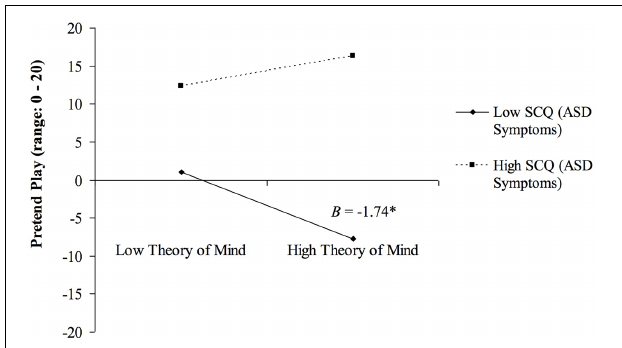
FIGURE 1 | Values below 0 are model-predicted values. Interaction between Social Communication Questionnaire [SCQ; i.e., history of many versus few autism spectrum disorder (ASD) symptoms] and theory of mind (ToM) Scale scores predicting amount of observed pretend play. Among those with low SCQ, a negative relation was found between ToM and pretend play. ∗ p < 0.05. Low = 1 SD below sample mean. High = 1 SD above sample mean.